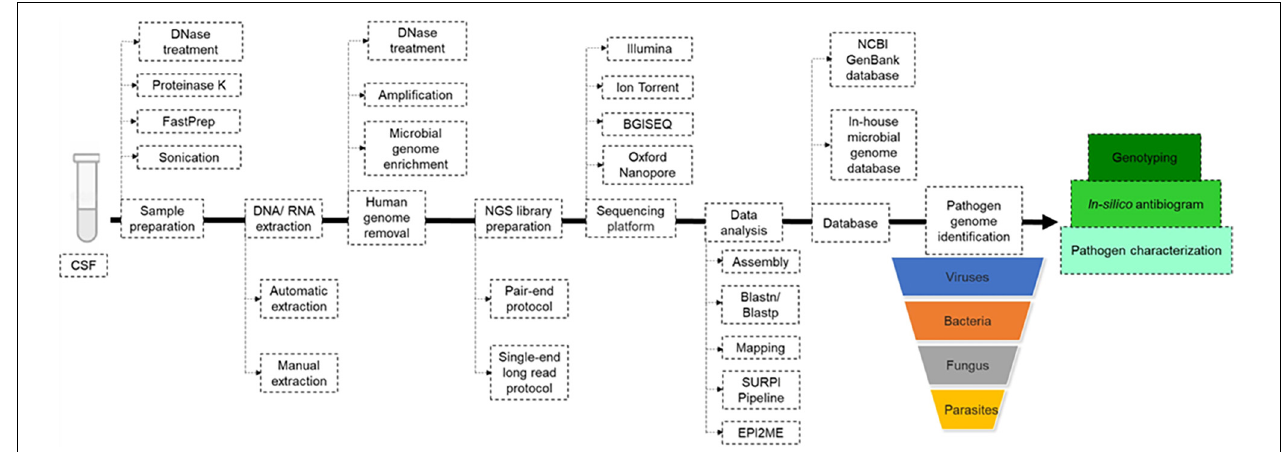
FIGURE 3 | Metagenomic next generation sequencing (mNGS) workflow. Upon reception of the cerebrospinal fluid (CSF), mechanical and enzymatic sample pre-treatment was performed before manual or automatic DNA/RNA extraction. Before mNGS library preparation, the human genome was removed with or without microbial genome enrichment, then mNGS libraries were prepared following pair-end or single-end long read protocol, depending on the sequencing platform. Pathogen genome identified directly by blast against NCBI GenBank and/or local microbial genome database downloaded from GenBank, using in-house pipelines. In-silico antibiogram and genotyping were performed depending on the nature of the identified pathogenic